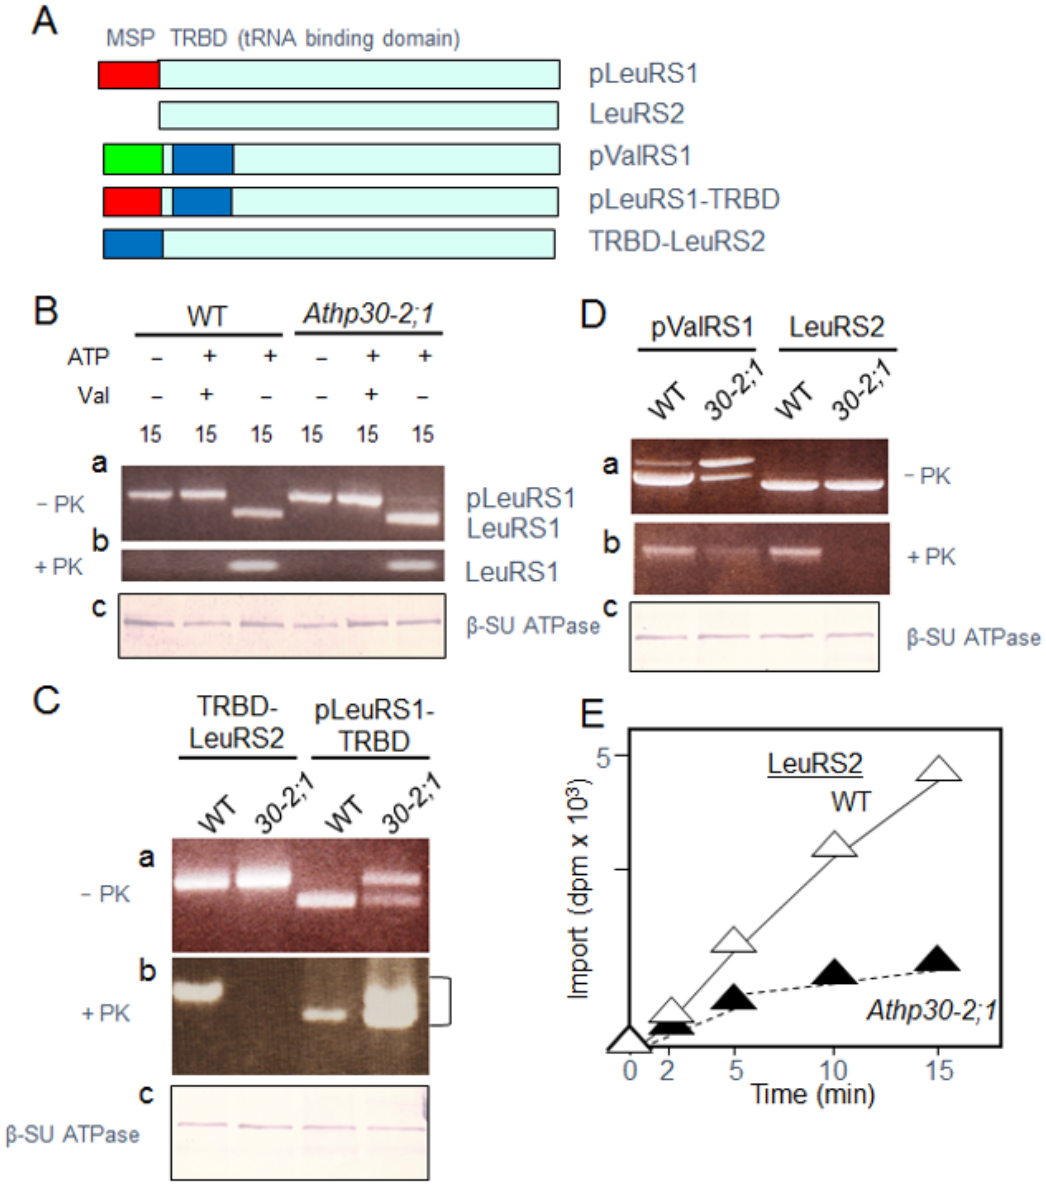
Figure 3. Mitochondrial import of pLeuRS1, LeuRS2, pValRS1 and engineered versions of pLeuRS1 and LeuRS2 containing the tRNA binding domain (TRBD, blue box) present in pValRS1. ( A ) Structure of the different AaRSs (not drawn to scale). MSP defines the mitochondrial signal peptide of pLeuRS1 (red box) and pValRS1 (green box). ( B ) Import of pLeuRS1 into mitochondria of wild-type (WT) and Athp30-2;1 plants. The assays were conducted at 23 ◦ C and contained ATP and valinomycine (Val), as indicated. Parallel assays were treated with (+ Prot. K) or without proteinase K (-Prot. K). Panels ( a,b ) show precursor and mature protein levels before ( − ) and after (+) proteinase K (Prot. K) treatment. Panel ( c ) depicts the result of a Western blot that was probed with an antibody against the β -subunit of the mitochondrial CF 0 /CF 1 -ATPase ( β -SU ATPase). ( C ) as ( B ), but showing the results of an import reaction carried out with TRBD-LeuRS2 and pLeuRS1-TRBD for mitochondria of wild-type (WT) and Athp30-2;1 plants. Incubations contained ATP but lacked valinomycin. ( D ) as ( C